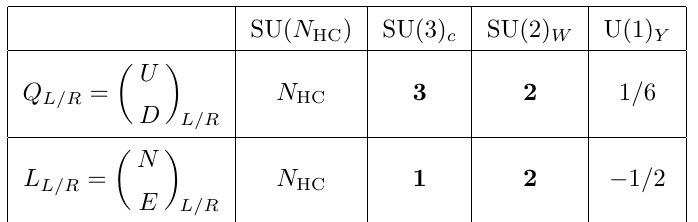
in the one-family